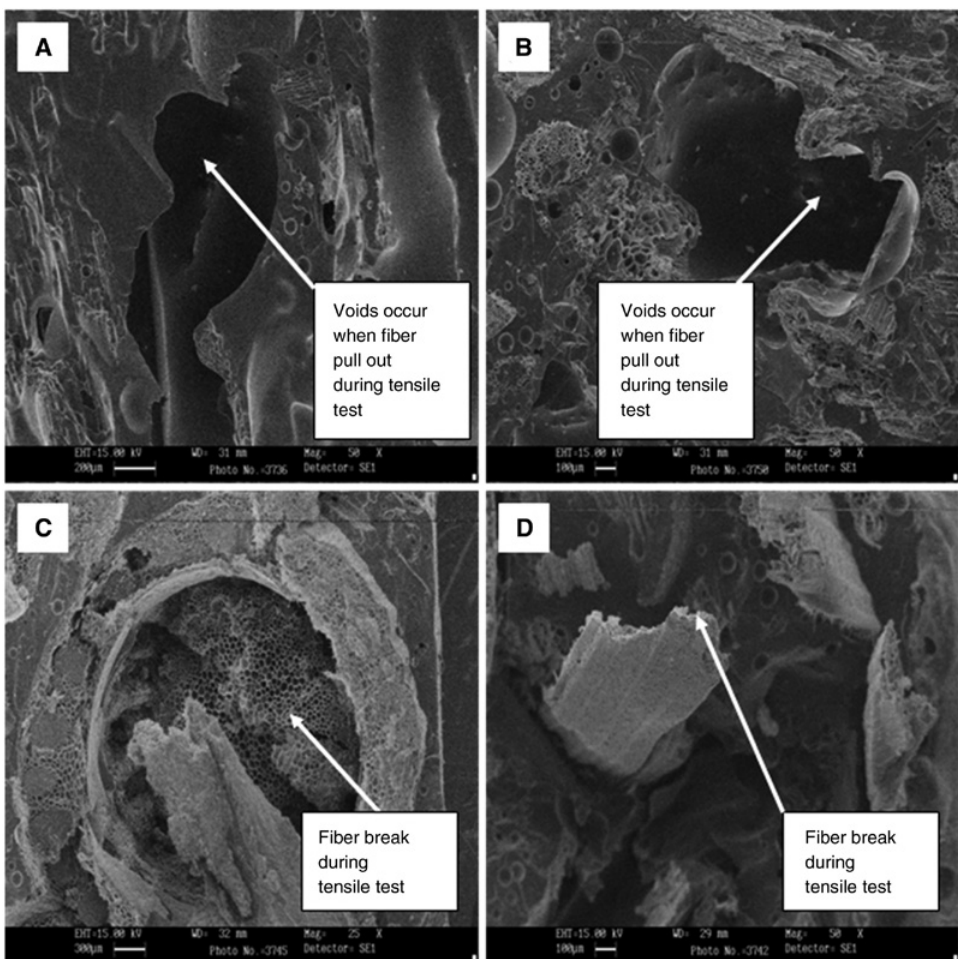
Figure 7: SEM morphology of tensile fractured surface of all composites: (A) untreated, (B) treated with 1% NaOH, (C) treated with 3% NaOH, and (D) treated with 5%